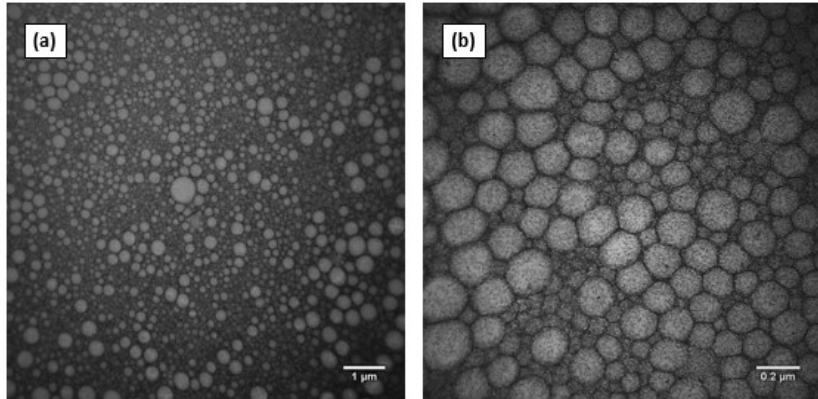
Figure 4. TEM of ZnPc nanoemulsion stained with negative contrast of 2% uranyl acetate obtained with magnification of ( a ) 20,000×; ( b ) 100,000×.